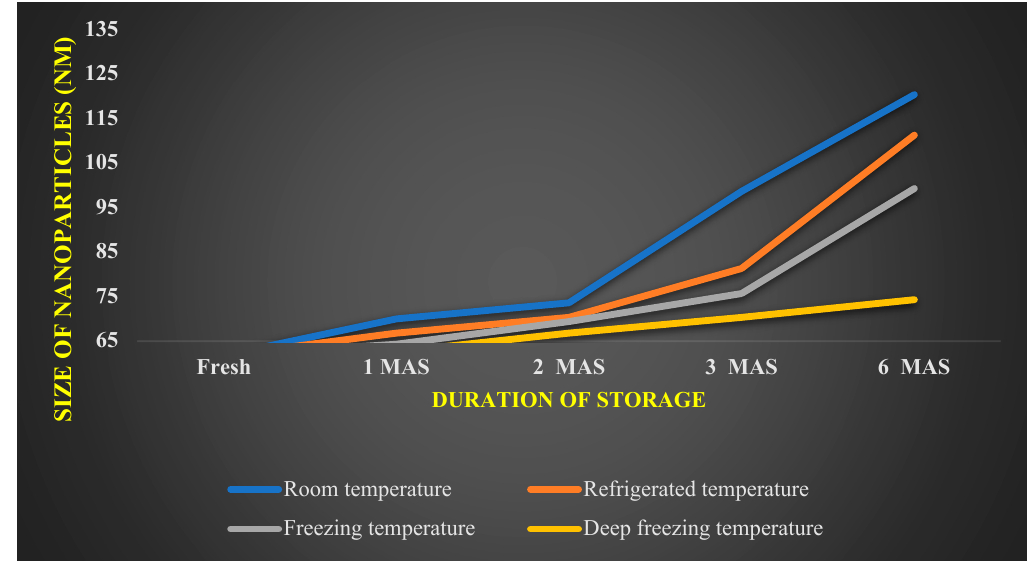
Figure 6. Zeta potential of A. indica -based AgNPs.